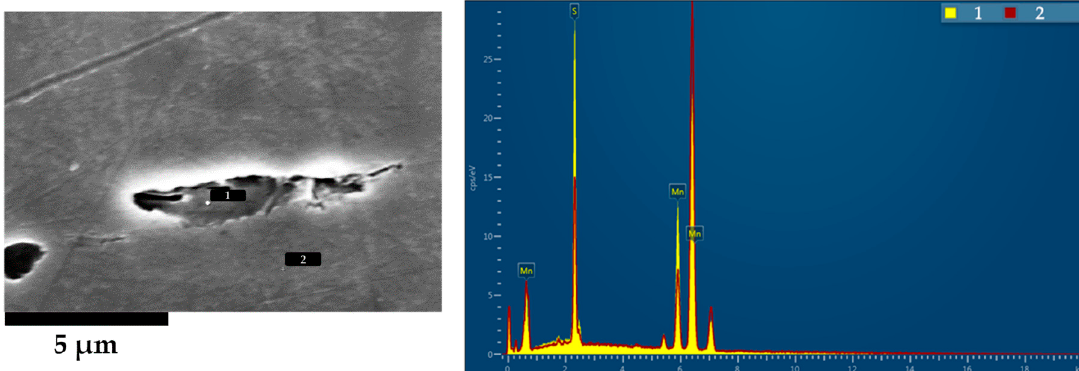
Figure 14. Compositional analysis of the observed particles in the FEI NovaNanoSEM 450 Scanning Electron Microscope (SEM) equipped with an Oxford X-max 50 X-ray detector (EDX).